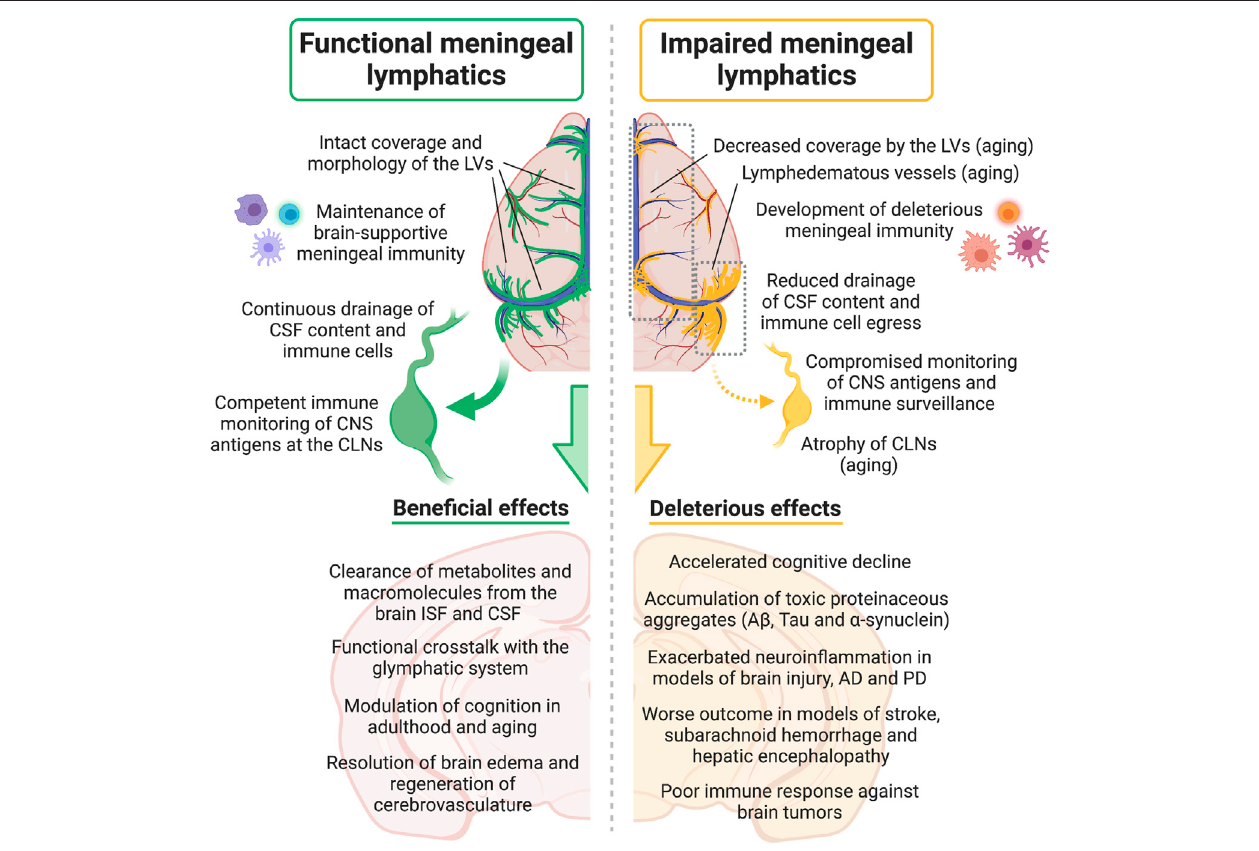
FIGURE2| Effectsofmeningeallymphatic(dys)functiononCSFdrainage,immunecelltraf fi ckingintothecervicallymphnodes,meningealimmunity,CNSimmune surveillance,neuroin fl ammationandotherneuralprocesses,eitherunderphysiologicalconditionsorindiseasemodels.A β ,amyloidbeta;AD,Alzheimer ’ sdisease;CNS, central nervous system; CSF, cerebrospinal fl uid; CLNs, cervical lymph nodes; ISF, interstitial fl uid; LVs, lymphatic vessels; PD, Parkinson ’ s disease. Created with BioRender.com.